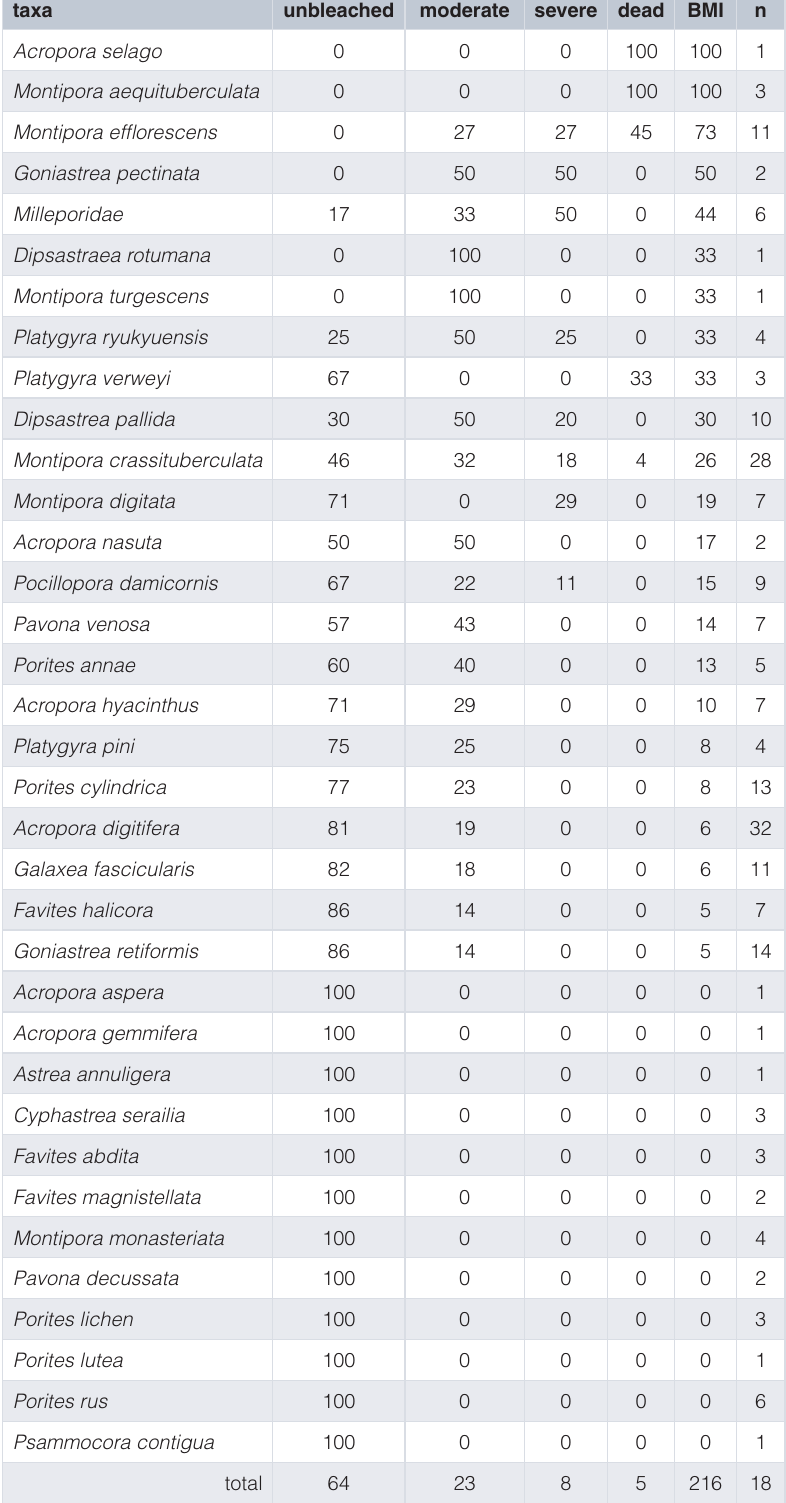
Table 1. Bleaching categories of hard corals at Nata Reef on 12 June 2016. BMI = Bleaching Mortality Index. taxa unbleached moderate severe dead BMI